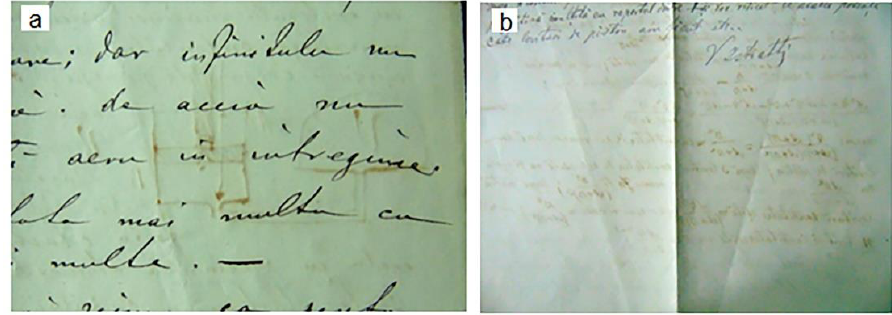
Figure 5. Migration of the sulfate anion with acid hydrolysis on the back of the page: ( a ) S2 and ( b ) S3.